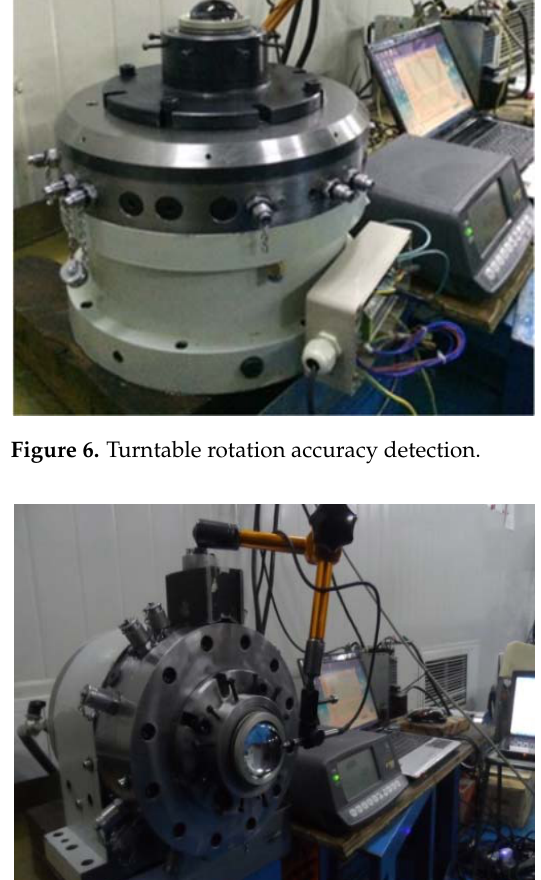
Figure 8. X ‐ axis and Z ‐ axis straightness, positioning accuracy, and repeated positioning accuracy test. 8. Grinding Test Figure 9 show that the grinding of the bearing raceway and the grinding process itself were reliable and effective. The use of an adhesive fixture was a major feature of this study. Figure 10 shows the grinding ‐ affected layer. The measuring equipment was a roundness meter. All of the comparison test results are shown in Table 8. Figure 9. Grinding process.